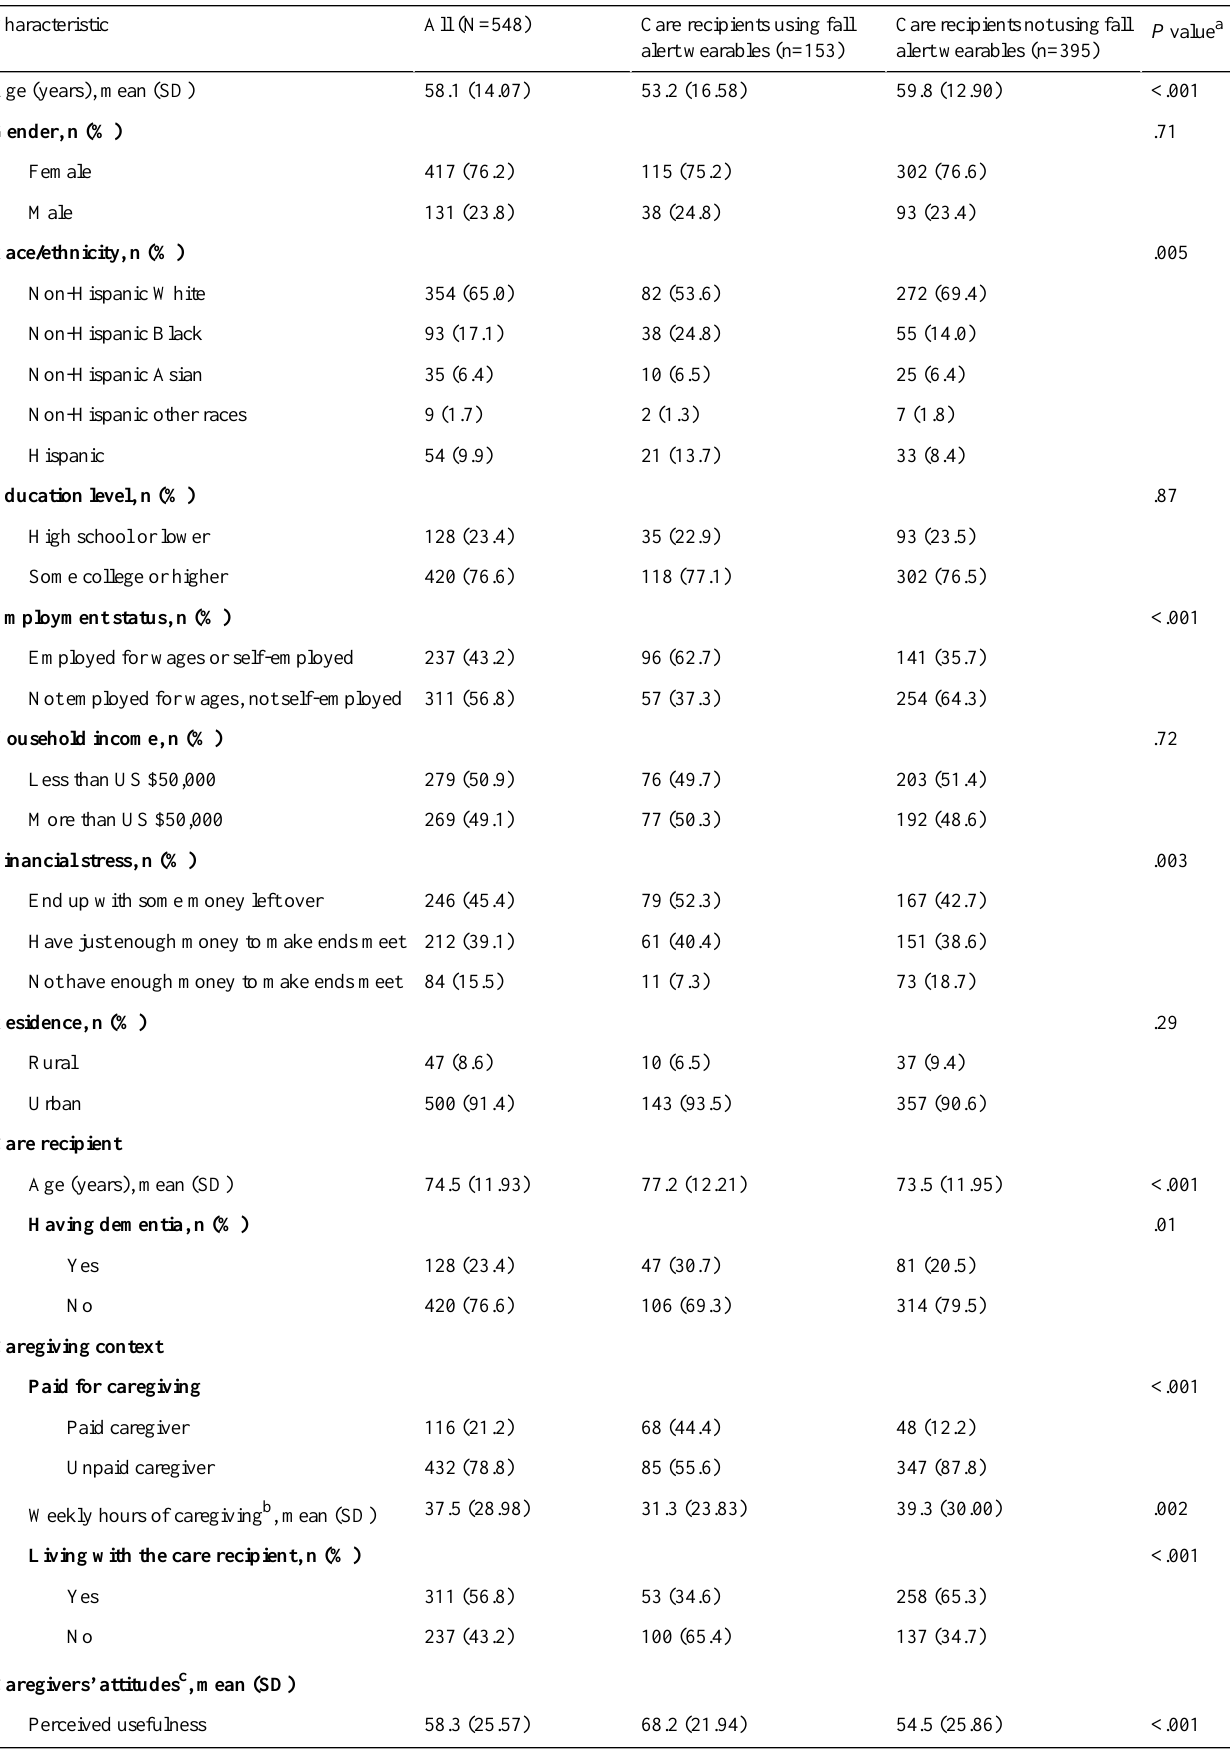
Table 1. Characteristics of the study respondents and caregiving context and caregivers’attitudes toward using technology in